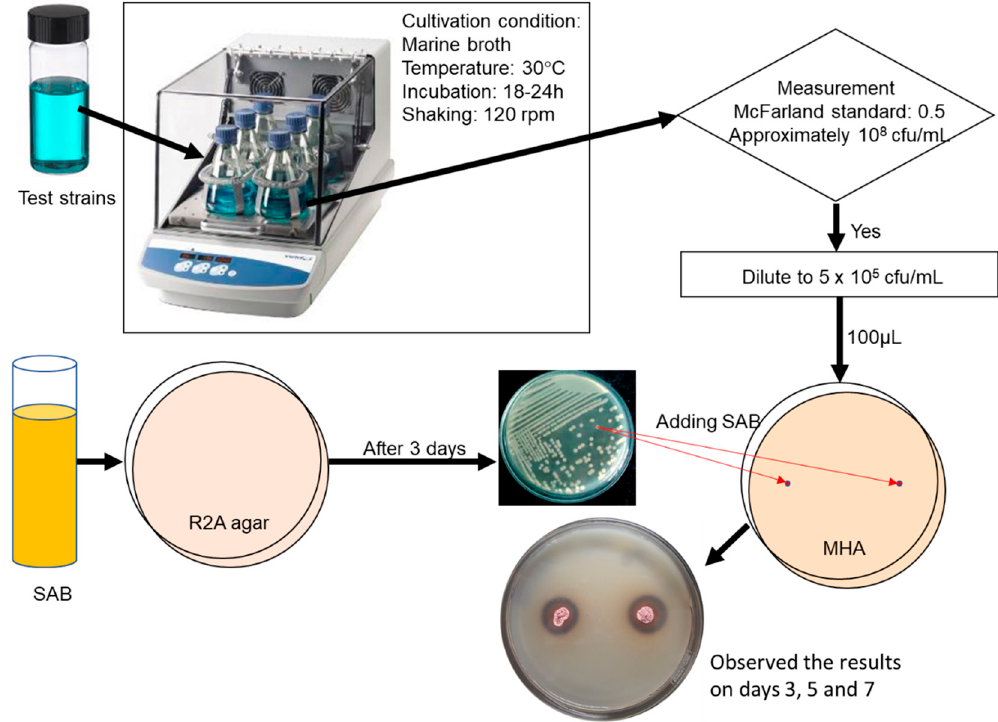
Figure 2. Flows chart of primary screening for antimicrobial activities for one test (SAB: sponge-associated bacteria; MHA: Mueller Hinton agar).